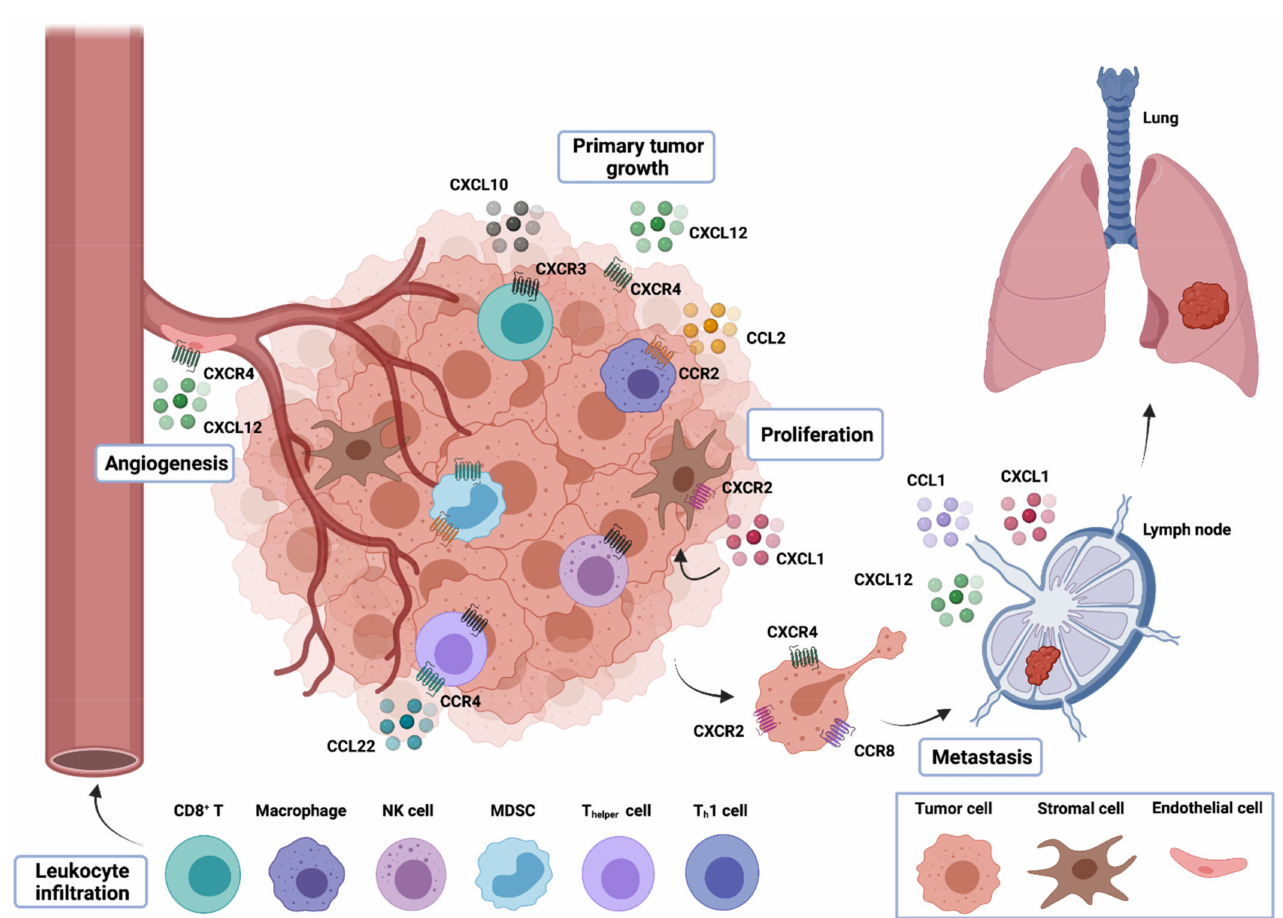
Figure 1. Multifaceted roles of chemokines in tumor development. Chemokines released by tumor cells, intratumor stromal cells, such as fibroblasts, and infiltrative leukocytes can recruit different immune cell types into the TME. The population of immune cells in the TME can interfere with the outcome of tumor development. While tumor- and stromal cell–derived chemokines can directly promote the growth, proliferation and survival of tumor cells, chemokines released by tumor cells, stromal cells and leukocytes can modulate the process of angiogenesis due to their angiogenic or angiostatic activity. Furthermore, chemokines produced within the tumor can induce the release of tumor-promoting growth factors that can act in a paracrine fashion to promote tumor growth. Finally, chemokines are also involved in the migration of tumor cells to distant sites for the development of